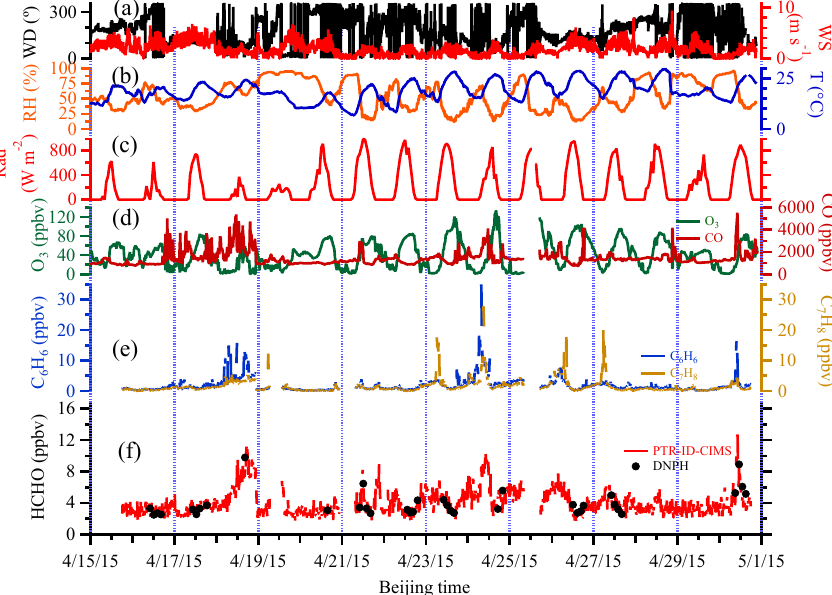
Figure 6. Time series of meteorological parameters (wind, RH, T , and solar radiation) ( a , b and c ), trace gases (O 3 and CO) (d) , benzene (C 6 H 6 ) and toluene (C 7 H 8 ) (e) , and HCHO (f) . The black dots in (e) are DNPH cartridge measurements of